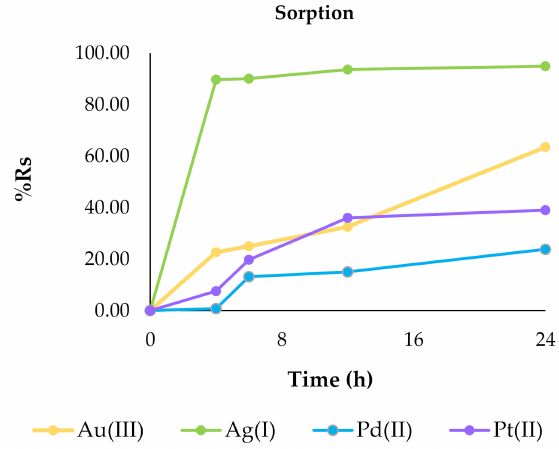
Figure 5. The percentage recovery of metals in the membrane (%R s ) after 24 h with 2,6-bis(4- methoxybenzoyl)-diaminopyridine as a carrier for gold(III), silver(I), palladium(II) and platinum(II) ions. The given values of %Rs carry ± 0.019.